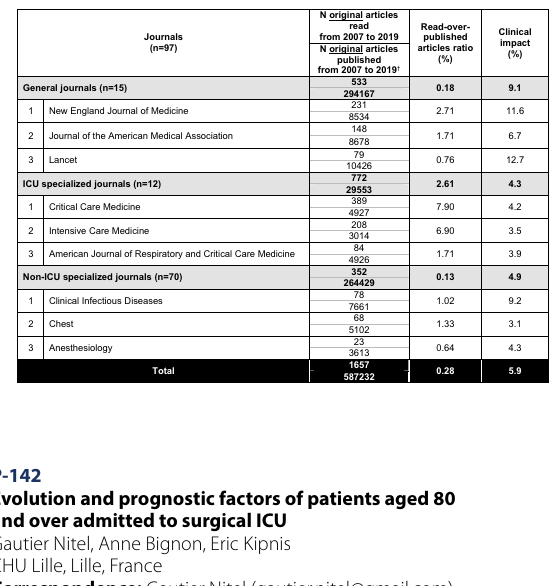
Table 1 Proportion of read‑over‑published articles and clini‑ cal impact of the 3 most read general, ICU and non‑ICU special‑ ized medical journals († number of original articles published from August 2007 to August 2019 only in the 97 journals read dur‑ ing our JC